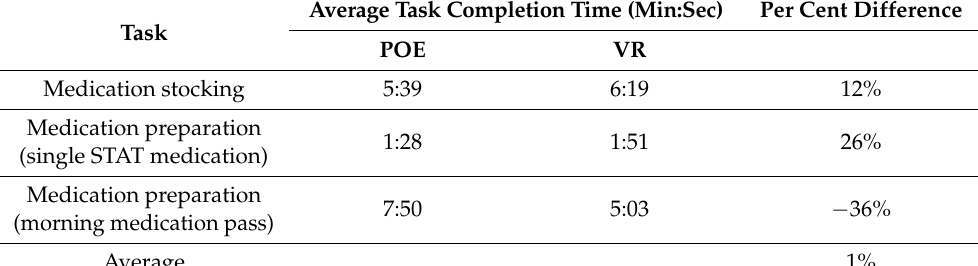
Table 3. Task completion times (averaged) for various tasks as measured during the POE and in the VR mock-up